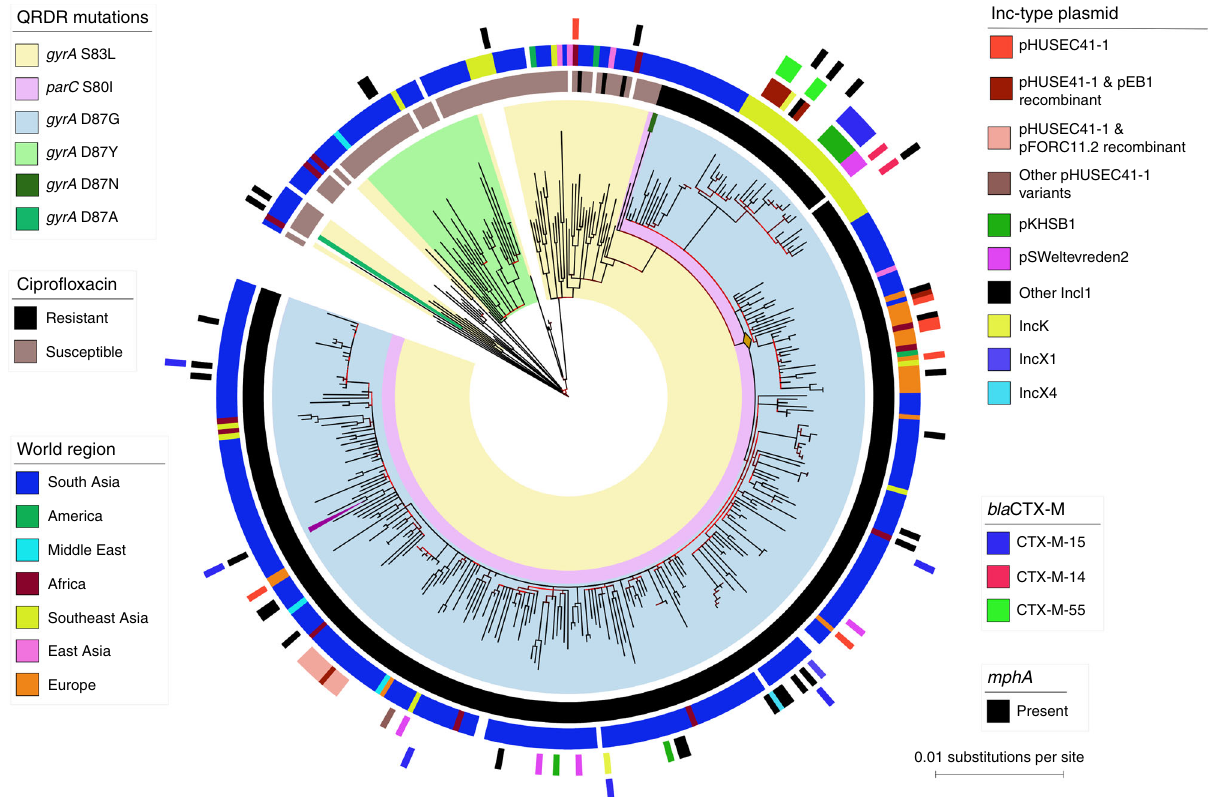
Fig. 1 The phylogenetic structure of CenAsiaIII Shigella sonnei . The fi gure displays the maximum likelihood phylogeny of 395 S. sonnei sequences belonging to the CenAsiaIII clade. The tree is rooted on the most closely related sequence from the S. sonnei global sequencing study. The branch colour scheme indicates bootstrap support for the corresponding branch, ranging from low to high (red to black). The shading covered on the phylogeny indicates taxa harbouring quinolone resistance determining region (QRDR) mutations (see key). The orange diamond indicates the internal node leading to the major fl uoroquinolone-resistant (FQr) clone. The magenta triangle denotes the position of taxon 2012 – 02037, which was subjected to long-read sequencing (see Methods). The rings show the associated information for each taxon, from the innermost to the outermost in the following order: (1) susceptibility testing for cipro fl oxacin (black: resistance; brown: susceptible); (2) original geographical source; (3) presence of different plasmids; (4) presence of ESBL bla CTX-M genes; (5) presence of mphA . The horizontal scale bar indicates the number of nucleotide substitutions per